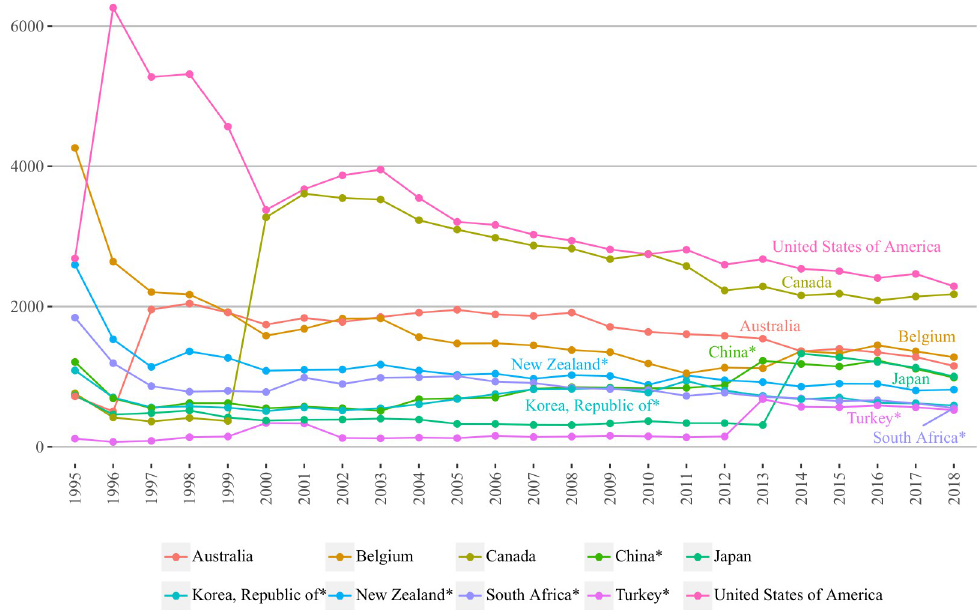
Fig 3. Betweenness centrality over 1995–2018 of top five BRI and non-BRI countries/regions. Countries/regions were selected based on the highest values of 2018 year; BRI marked with ‘ � ’.